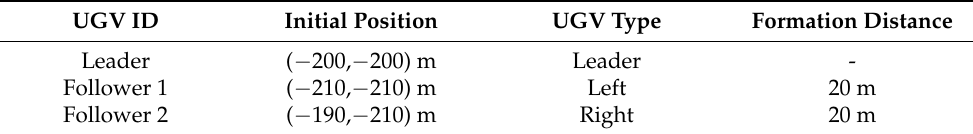
Figure 14. Trajectory of UGV basic formation. The black area represents obstacles, and the red line, green line and blue line represent the trajectories of the leader, the follower 1 and the follower 2 respectively. Table 3. List of Parameters Used in the Testing of a Basic Single-layer Triangle Formation.